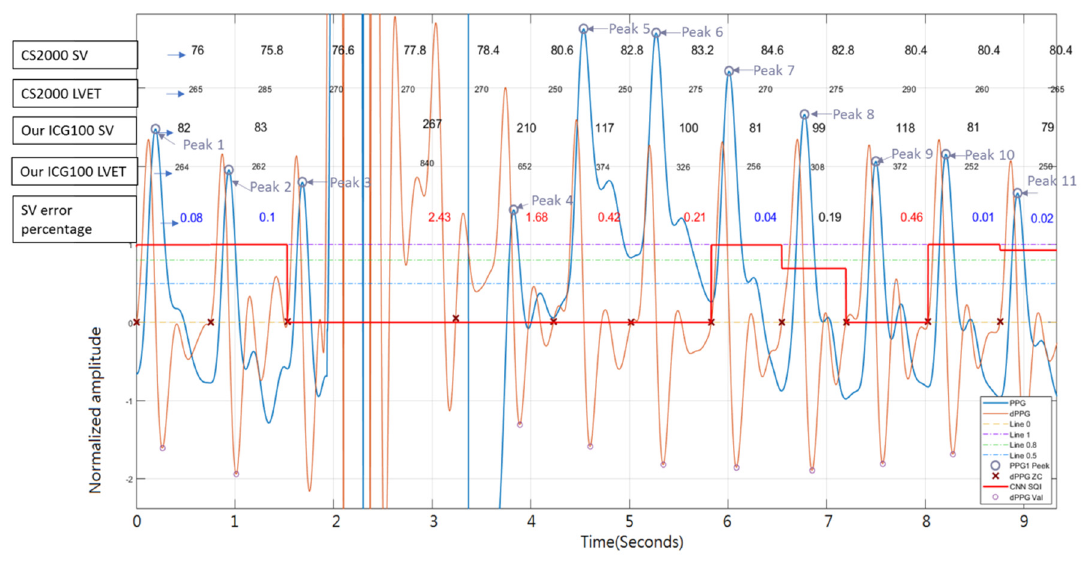
Figure 9. The results of SQI classification with the ResNet-50 model for the PPG (blue line) and DPPG (orange line) signals corrupted by serious baseline drift. The first and third rows of the data are the two SVs with medis ® CS 2000 and our ICG device, respectively, while the second and fourth rows are the two LVETs with medis ® CS 2000 and our ICG device, respectively. The fifth row represents the error percentages of SV. The red line denotes the output value of the ResNet-50 model. The cross and circle symbols represent the first zero-crossing point and minimum-value point of the DPPG pulse, respectively.